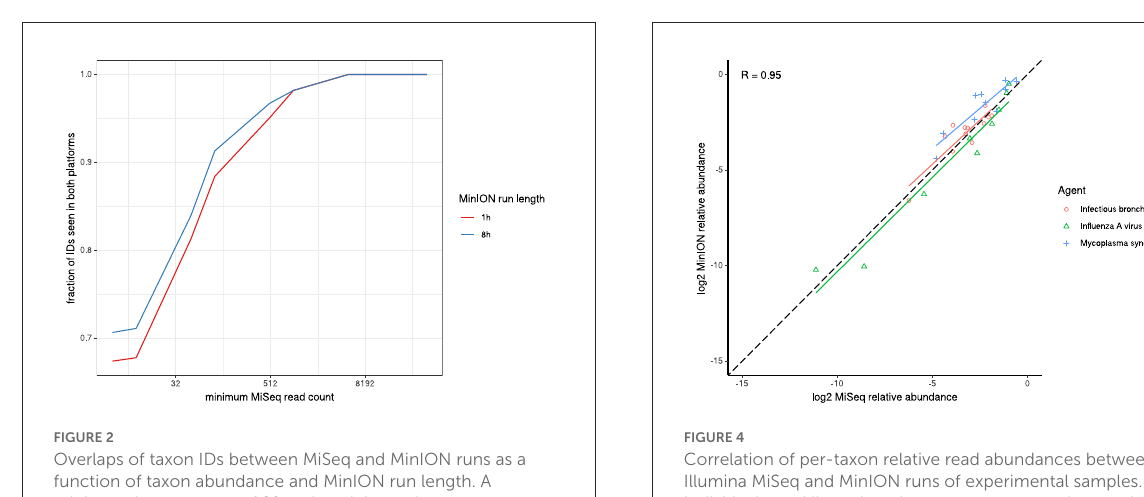
FIGURE2 Overlaps of taxon IDs between MiSeq and MinION runs as a function of taxon abundance and MinION run length. A minimum k-mer count of 20 and a minimum b-score (subsampled BLAST agreement) of 0.7 was calculated from IDs.